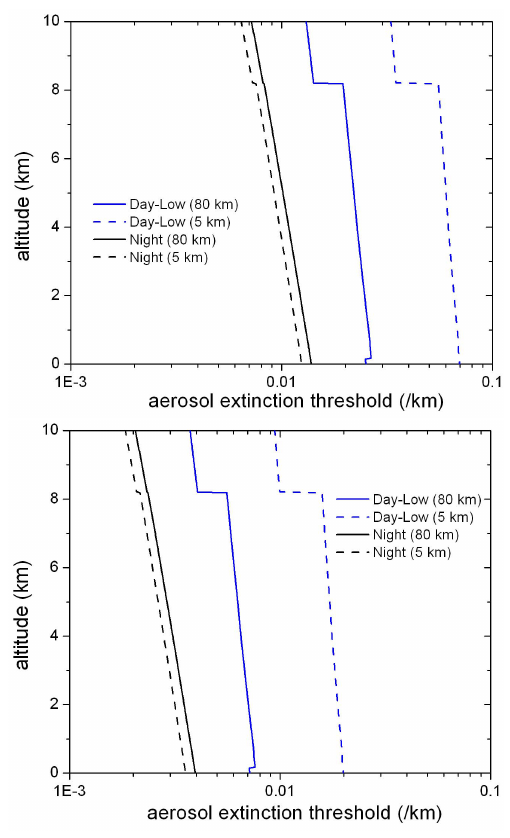
Fig. 1. Detection thresholds used in Level 2 data processing, in terms of 532nm aerosol extinction. Upper panel: smoke ( S =70sr); Lower panel: marine ( S